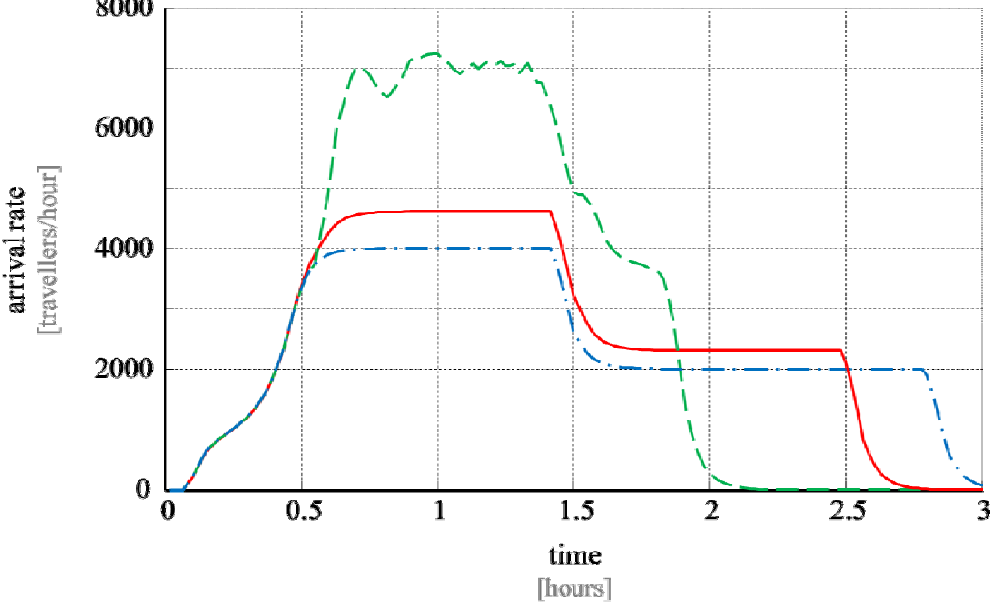
Figure 11. Network outflow rates: red solid line, information level 3; green dashed line, information level 8; blue dash-dotted line, information level 10 (see Table